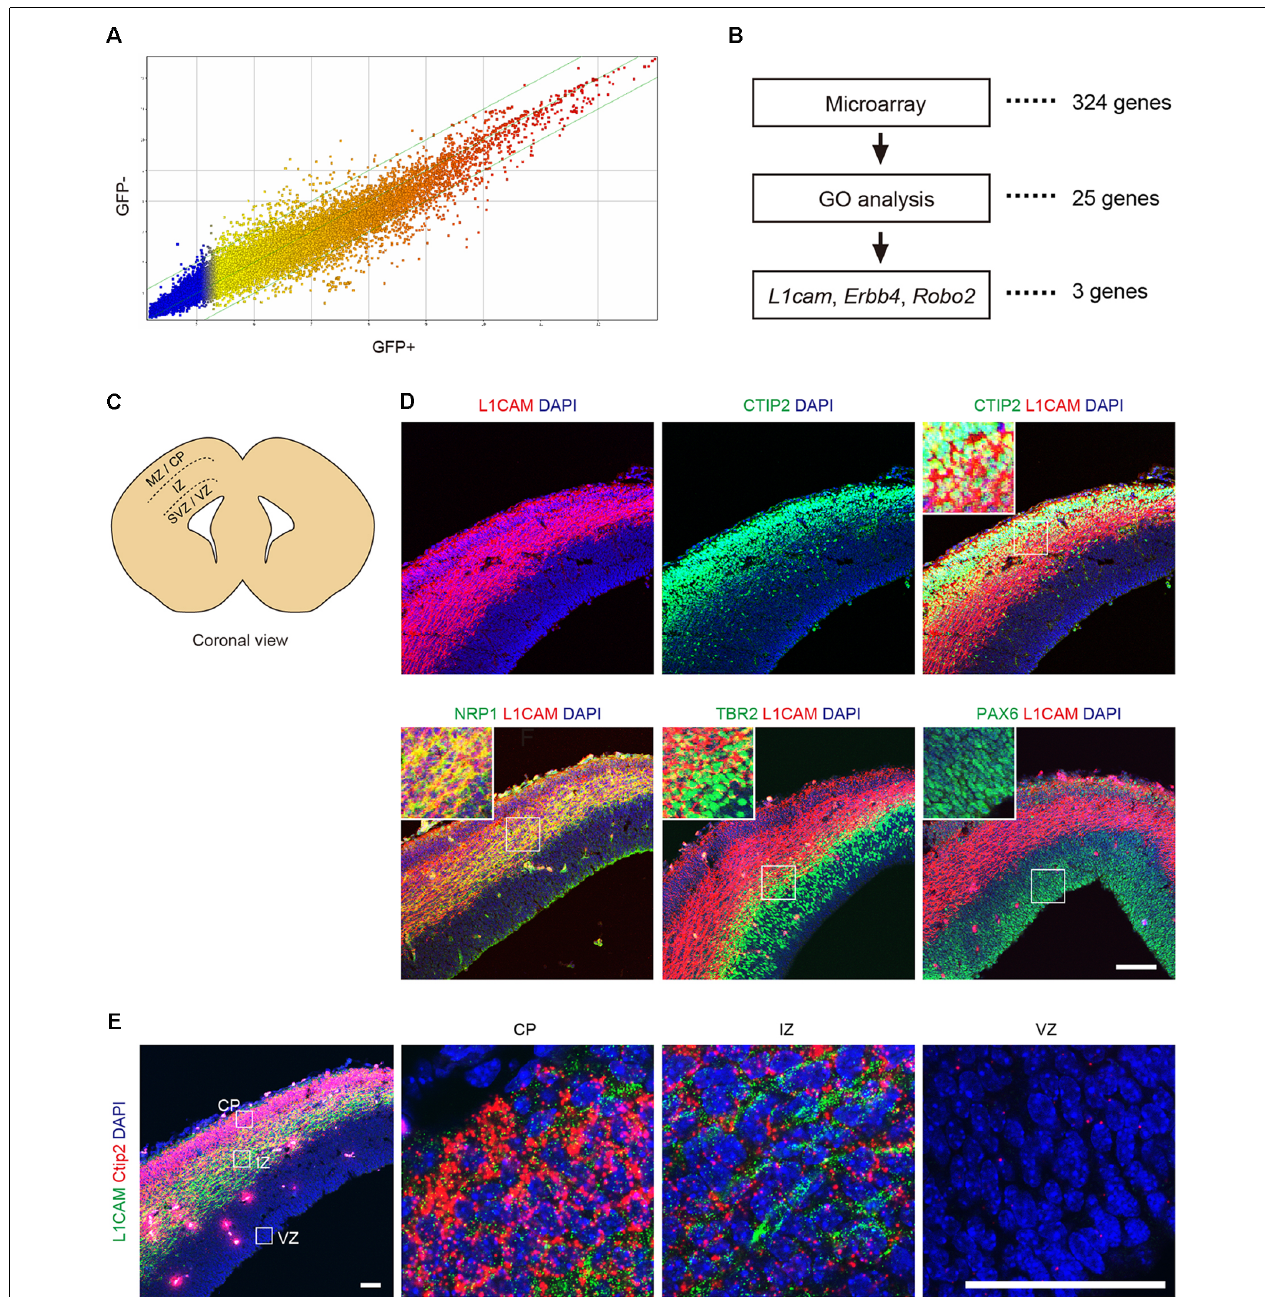
FIGURE 3 | L1CAM is a marker for CTIP2 of E14.5 mouse. (A) Comparison of the gene expression profiles between GFP + and GFP − cells in CTIP2:GFP KI mESCs on day 11 to day 13. (B) Screening of the candidate molecules by microarray analysis, gene ontology (GO) analysis and literature. First, the microarray analysis revealed 324 genes as 2-fold upregulated in CTIP2:GFP + cells. Next, 25 genes were identified by GO analysis as the plasma membrane. Finally, three genes were selected from the literature as expressed in the cell body. (C) Diagram of the brain slices of the E14.5 mouse frontal cortex. (D) Immunofluorescence images for CTIP2 (green), NRP1 (green), TBR2 (green), PAX6 (green), L1CAM (red) and DAPI (blue). Scale bar represents 100 µ m. (E) Immunofluorescence image for L1CAM (green) and RNA FISH image for Ctip2 (red) and DAPI (blue). Scale bars represent 50 µ m.